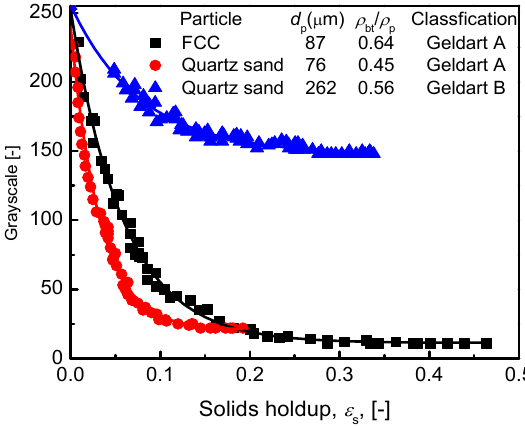
of the grayscale, reflecting the influence of the particle properties on the fluidization qual ‐